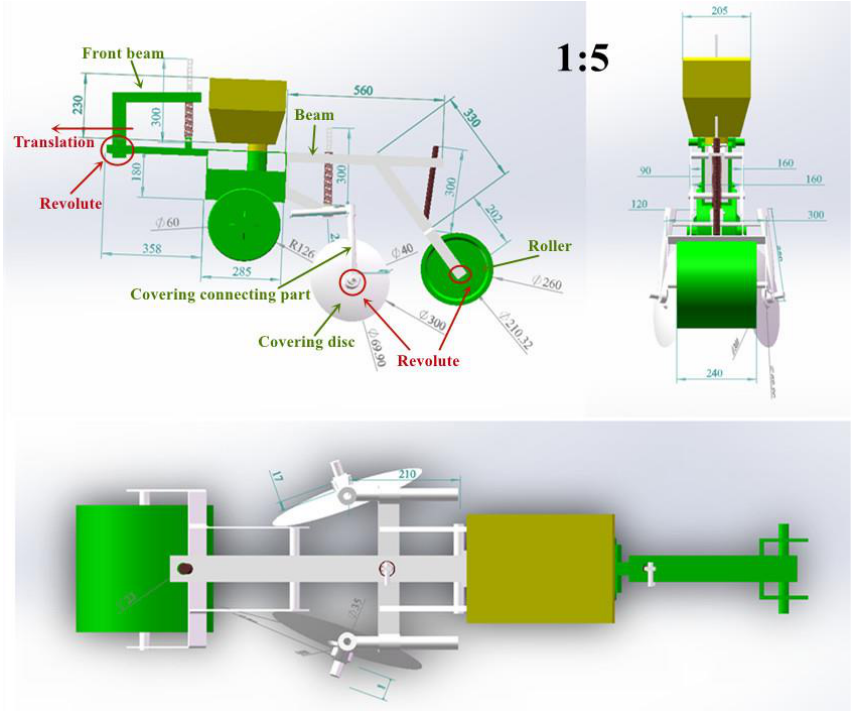
Figure 8. The influence of the soil compacting process on the changes in sowing depth with various forward velocities.